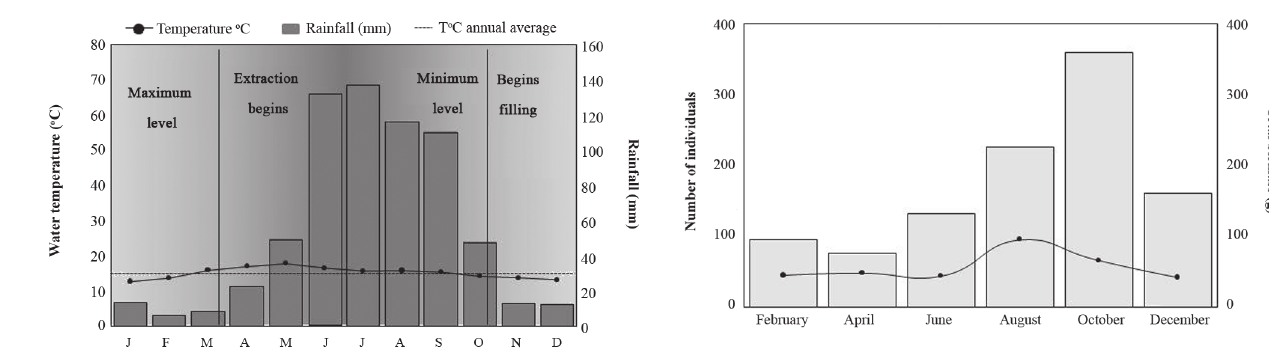
Fig. 5. General structure of the population of San Martín mexcalpique. The numbers in parentheses indicate the percentage of each size class of the total population.